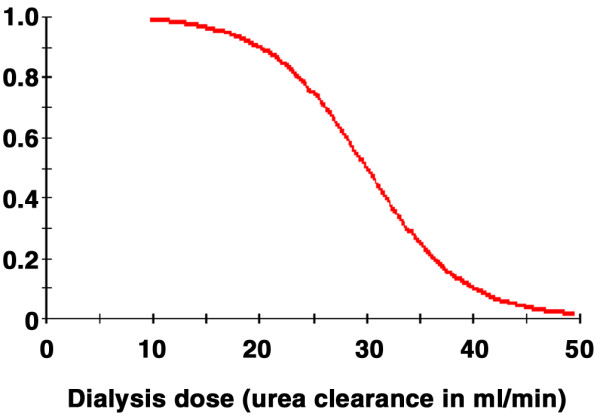
Mortality rate as a function of dialysis dose (expressed as urea clearance ml/min).